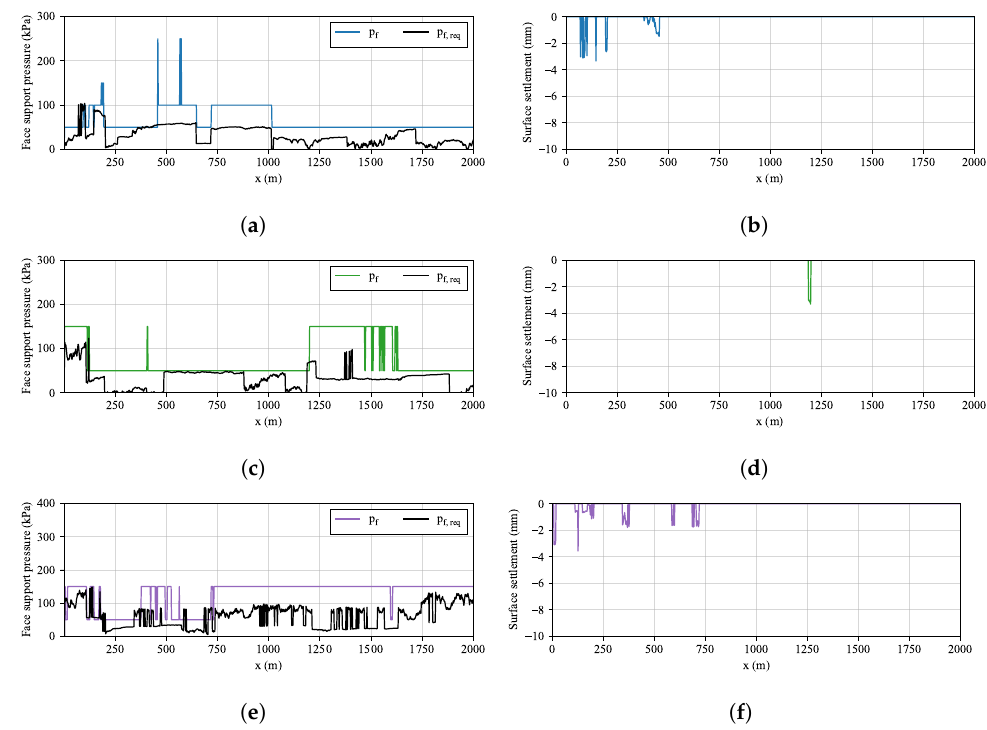
Figure 9. Required and provided support pressures and settlement in the analytical environment with random geologies at episodes ( a , b ) 1, ( c , d ), 50 and ( e , f ) 100. Table 4. Mean rewards and standard deviation of the random environment for different values of ε 0 . ε